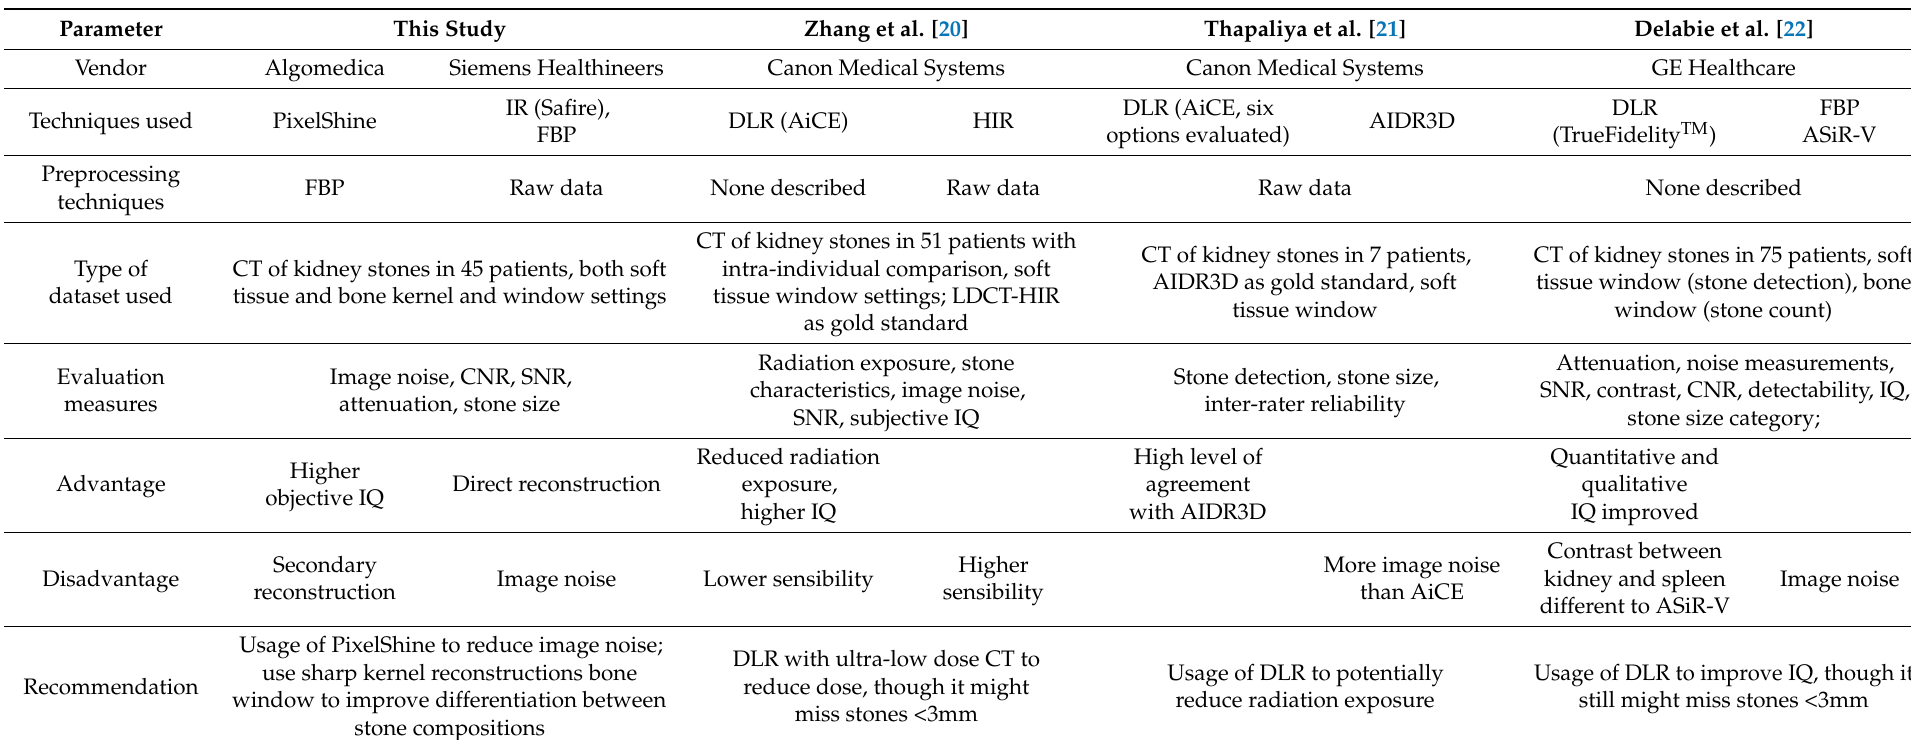
Table 5. Comparison of deep-learning based reconstruction tools employed for the diagnosis of kidney and ureter